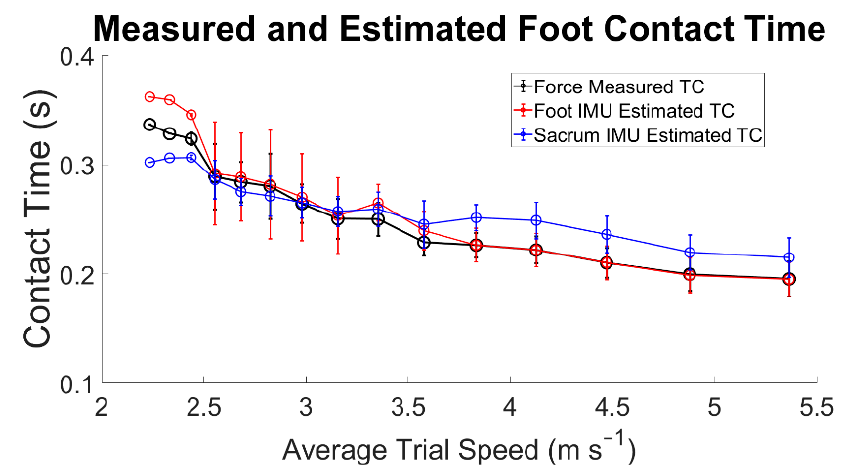
Figure 5. Differences in force ‐ measured and IMU ‐ estimated contact time across the range of average speed trials. The sample sizes for each speed are shown in Table 1.